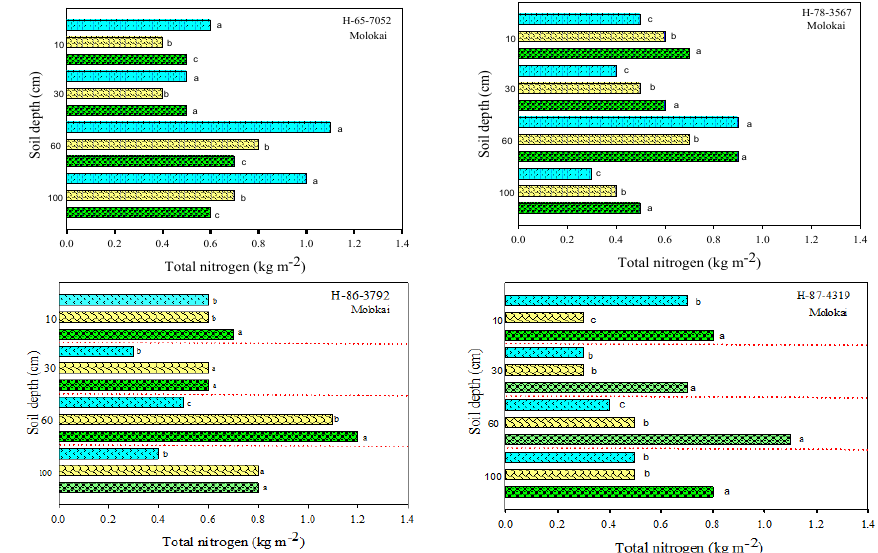
Figure 6. Total Nitrogen in Molokai soils. Color represents sugarcane growing stages ( i.e. , blue-tillering, yellow-grand growth, green-maturity) when the soil samples were collected. Means followed by the same letter or no letters for the bars in each soil depth are not significantly different Tukey’s test at Pr <